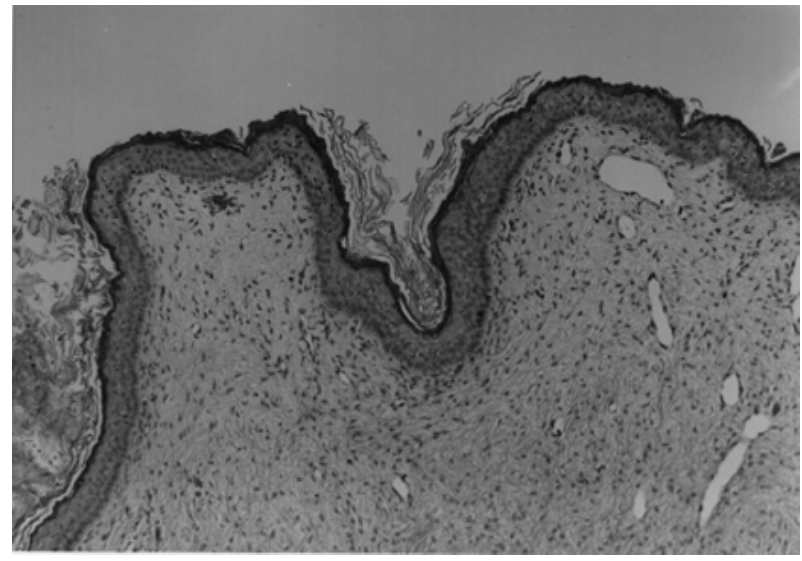
FIGURE 3. Microscopic examination of the bladder illustrating hypertrophy of the muscularis propia from chronic obstruction.